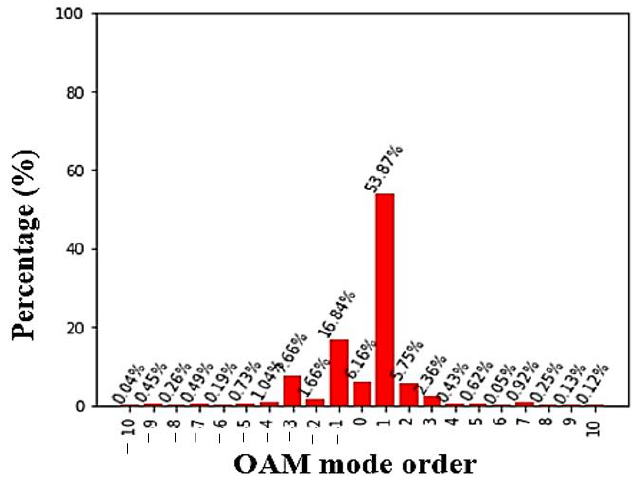
Figure 10. Mode purity of OAM mode +1 at 3.56 GHz.